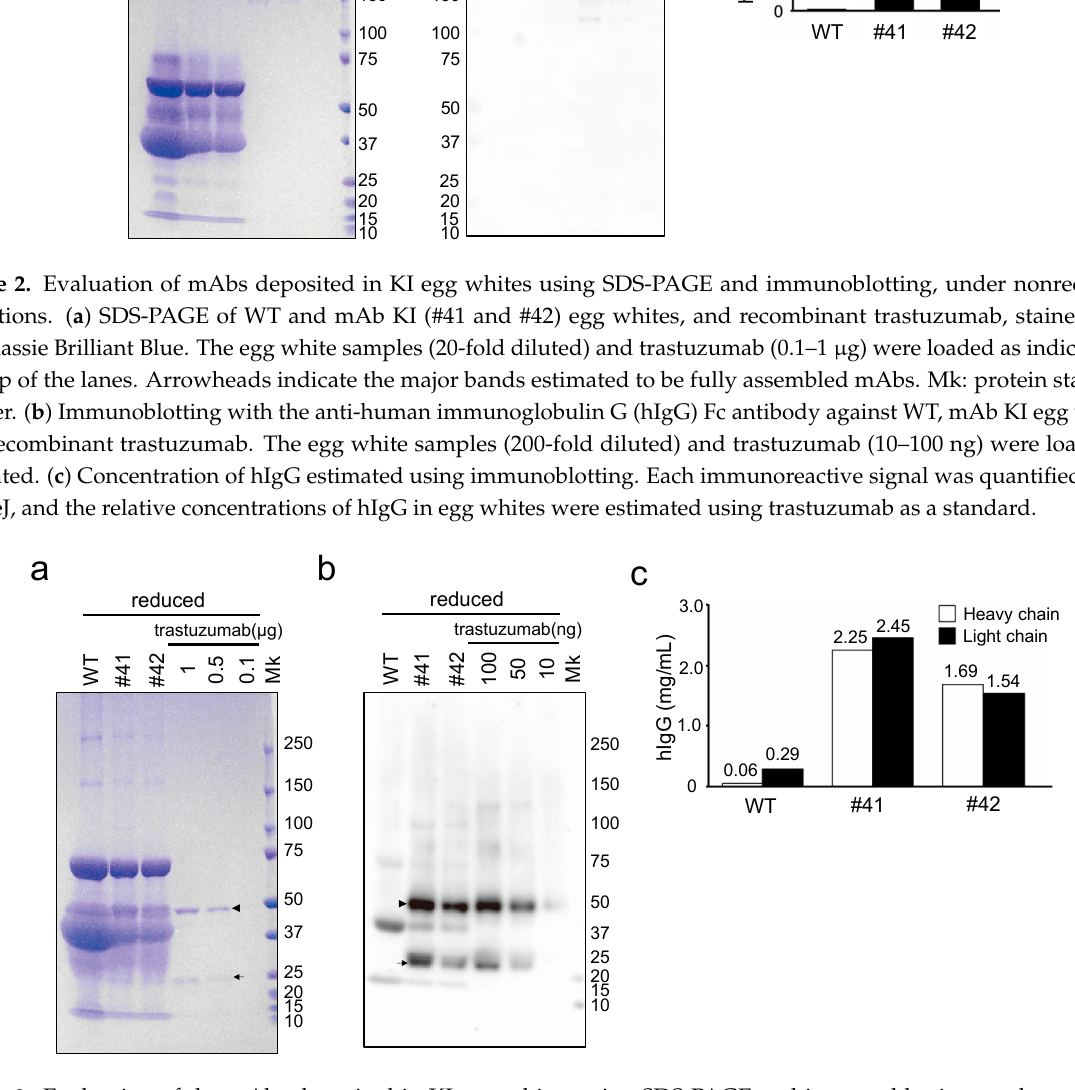
Figure 3. Evaluation of the mAbs deposited in KI egg whites using SDS-PAGE and immunoblotting, under reducing conditions. ( a ) SDS-PAGE of WT egg whites, mAb KI (#41 and #42) egg whites, and recombinant mAb trastuzumab, stained with Coomassie Brilliant Blue. The egg white samples (20-fold diluted) and trastuzumab (0.1–1 µ g) were loaded as indicated at the top of the lanes. The arrowhead and arrow indicate the position of the heavy and light chains of hIgG, respectively. Mk: protein standard marker. ( b ) Immunoblotting with the anti-hIgG (H + L) antibody against WT, mAb KI egg whites, and recombinant trastuzumab. The arrowhead and arrow indicate the position of the heavy and light chains of hIgG, respectively. ( c ) The concentration of hIgG as estimated by immunoblotting with trastuzumab as the standard. Immunoreactive signals corresponding to the heavy and light chains were quantified using ImageJ and are represented using white and black bars,